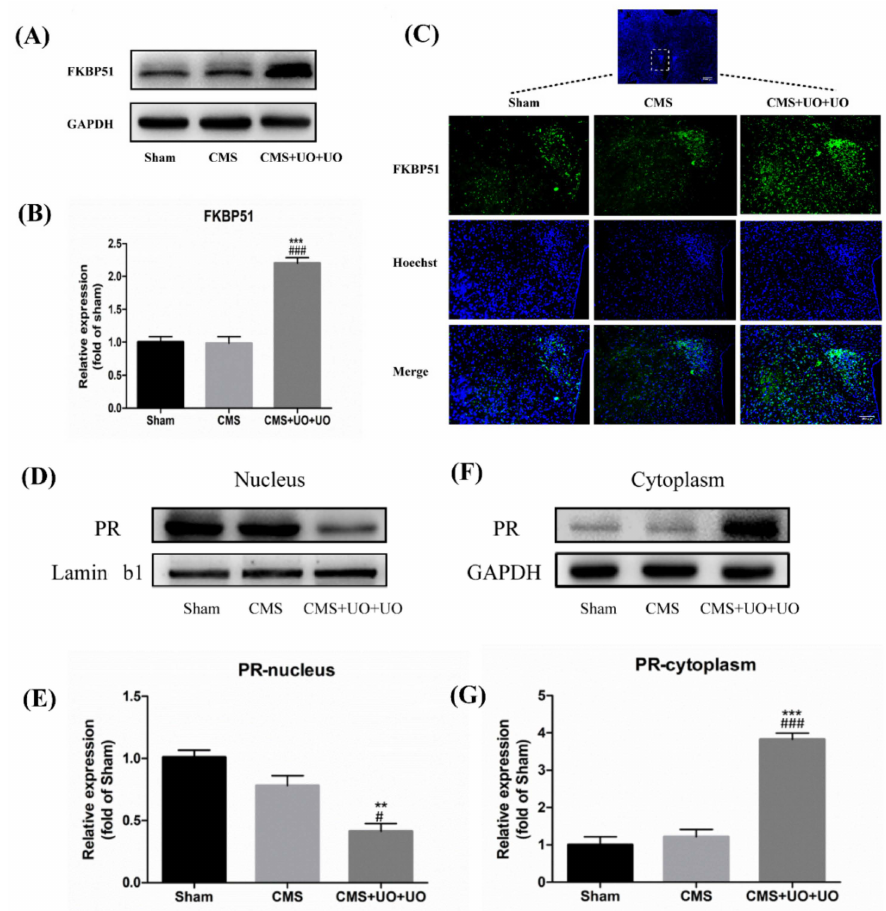
Figure 4. Hypothalamic progesterone (PR) nuclear translocation decreased and FKBP51 was upregulated in peri / postmenopausal depression. ( A – C ) The expression of FKBP51 in the hypothalamus was detected by western blot and immunofluorescence. ( D – G ) The expression of PR in the nucleus and cytoplasm of the hypothalamus was detected by western blot using Lamin b1 and GAPDH as loading controls. Data are presented as means ± SEMs, n = 4–5, ** p < 0.01, *** p < 0.001 versus sham; # p < 0.05, ### p < 0.001 versus CMS